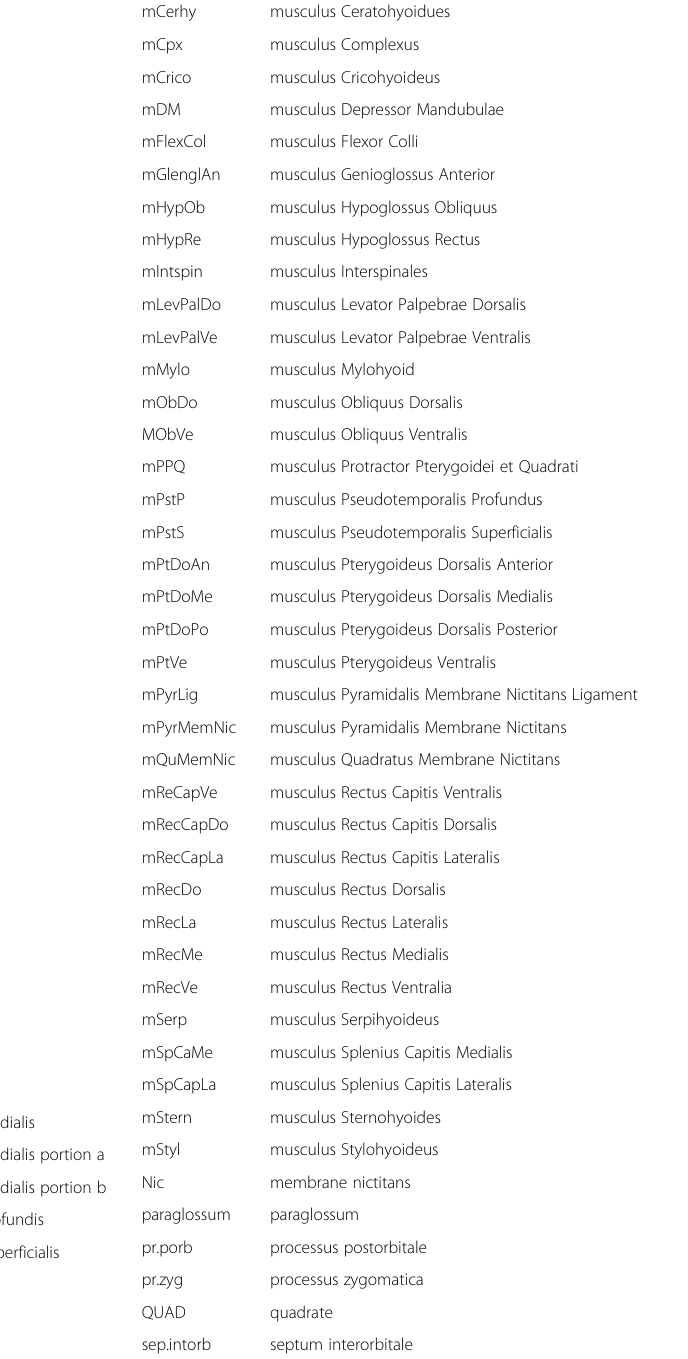
Table 2 Abbreviations used throughout the figures and manuscript text. Bones are in all uppercase. Muscles and glands are in title case following a lower case m or g, ligaments are in title case following a capital L, and specific features are all